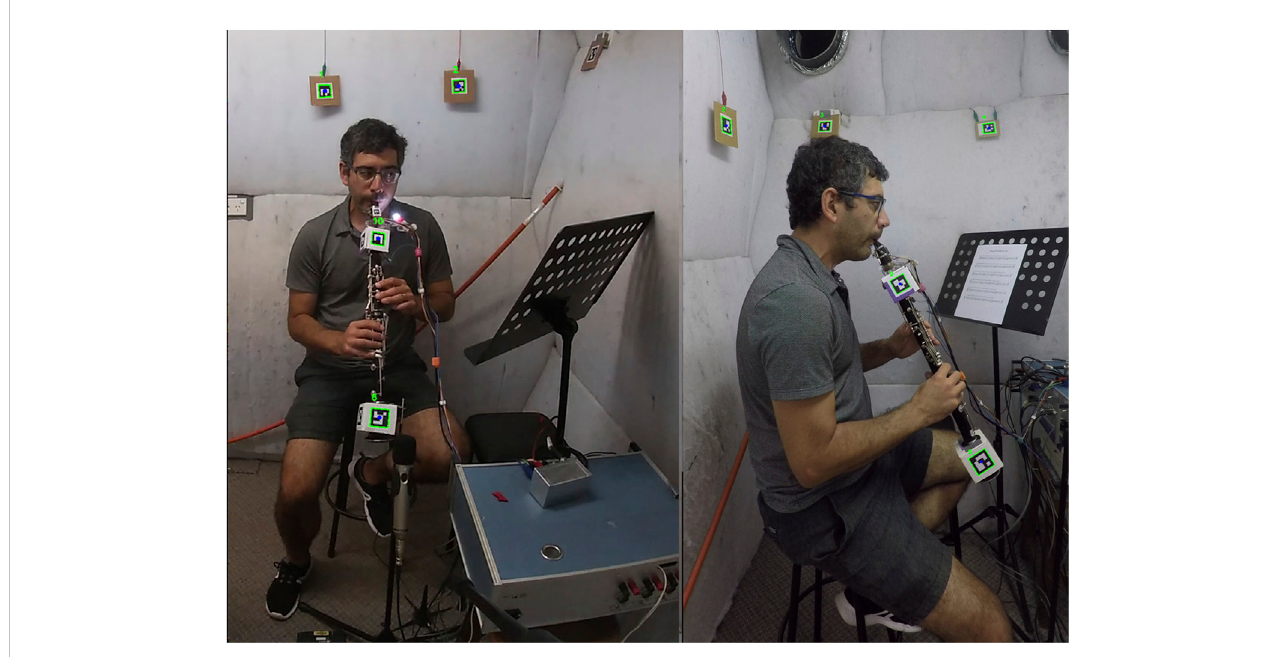
FIGURE 3 Synchronised capture of front and side views of player. Green rectangles show the detected ArUco markers tracking the motion of the clarinet.